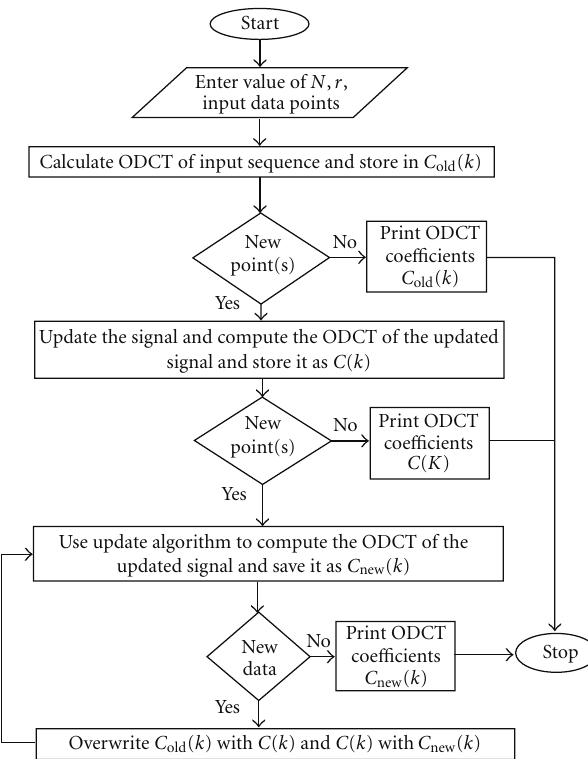
Figure 1: Flow chart of independent update